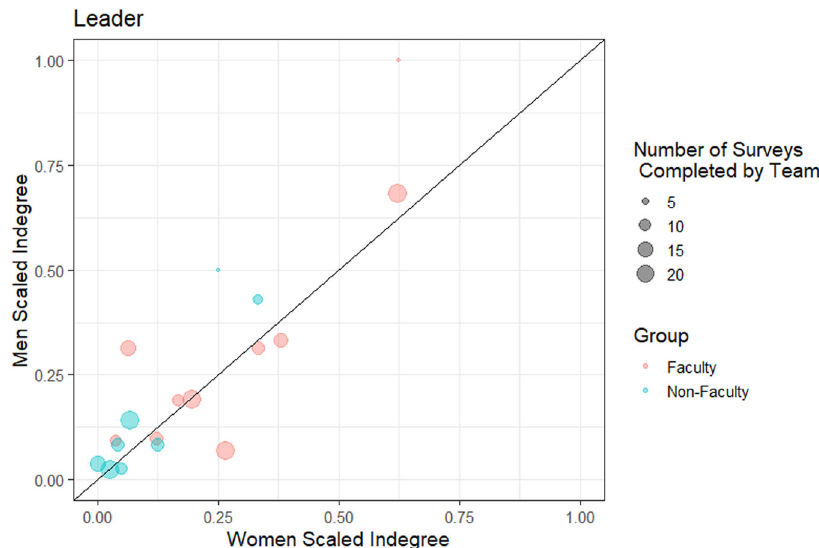
Fig. 2 For each team, the average scaled indegree in the leader network for women and men, and faculty and nonfaculty was computed. The values for men and women for each of the faculty types are plotted against one another. Faculty were more likely to be considered leaders than non-faculty, but there were no signi fi cant differences between reporting men or women as leaders on scienti fi c teams.